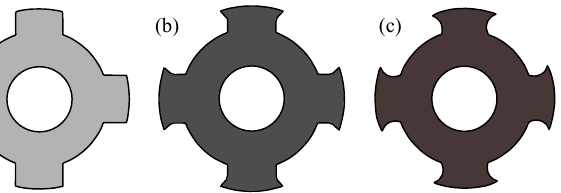
Figure 3. Comparison of rotor pole topologies: ( a ) conventional, ( b ) design from [37] to reduce radial forces, and ( c ) improved design from [34].